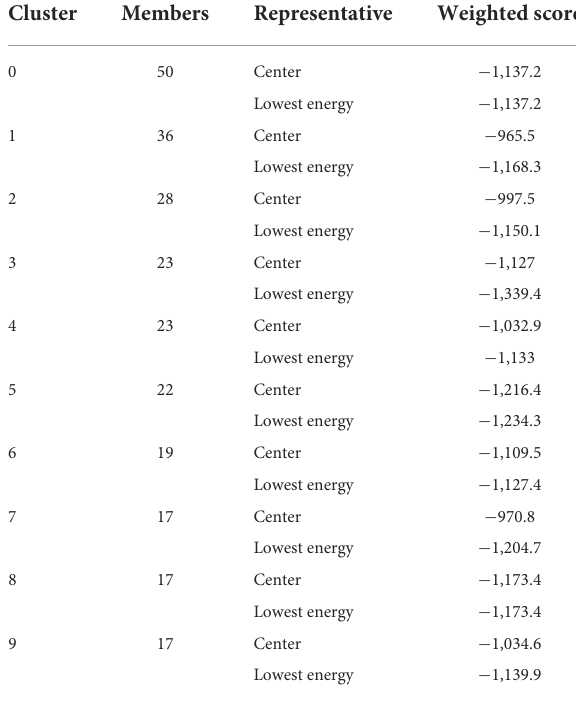
TABLE 4 Models for the docked complexes of TLR5 and designed